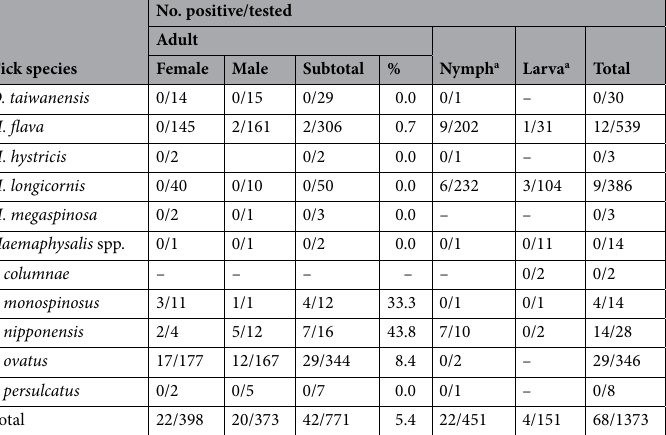
Table 3. Prevalence of rickettsial genes detected from ticks by PCR. a Shown by no. pool (2 to 5 ticks/sample).